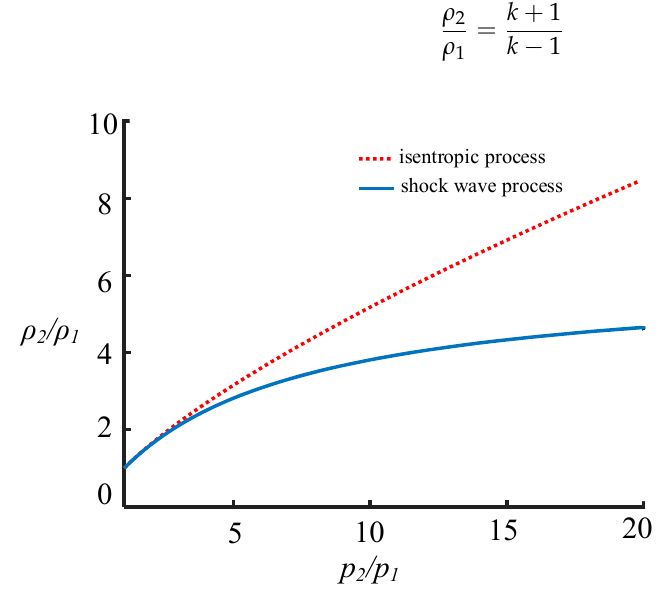
Figure 8. Comparison of density changes in isentropic and shock processes.